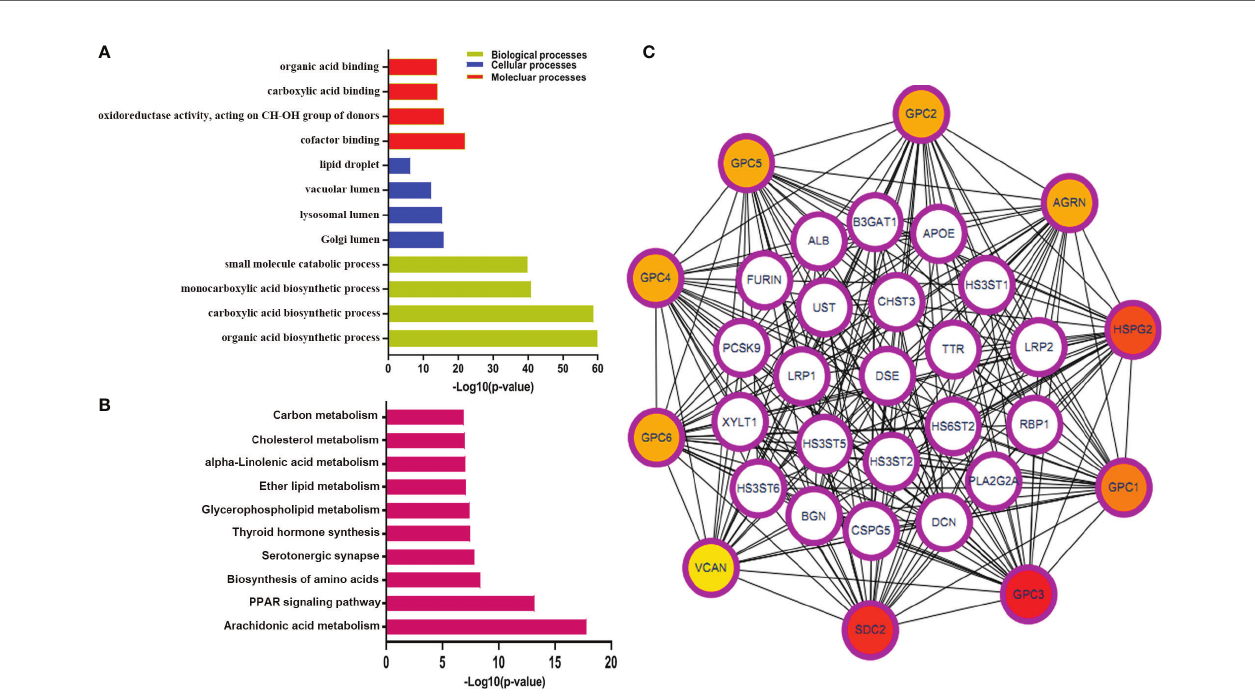
FIGURE 2 | The GO and KEGG pathway analysis for immune-related metabolic genes. (A, B) The GO enrichment and KEGG pathway analyses of immune-related metabolic genes; (C) The top 10 genes were ordered by the number of nodes. BP, biological process; CC, cellular component; MF, molecular function; KEGG, Kyoto Encyclopedia of Genes and